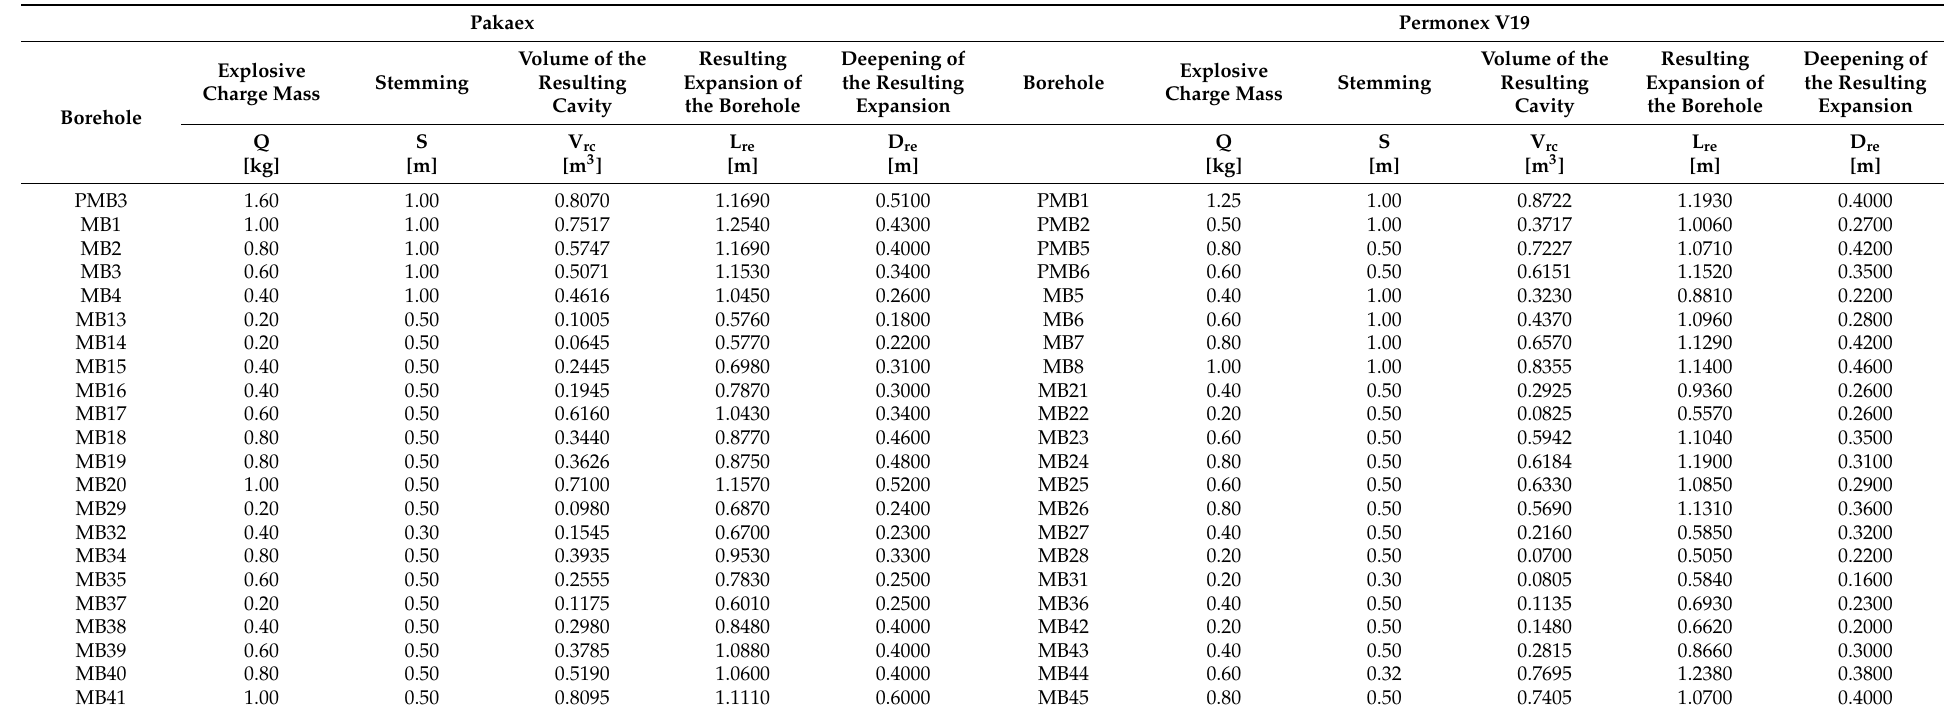
Table 1. The results of blasting for explosive Pakaex and Permonex